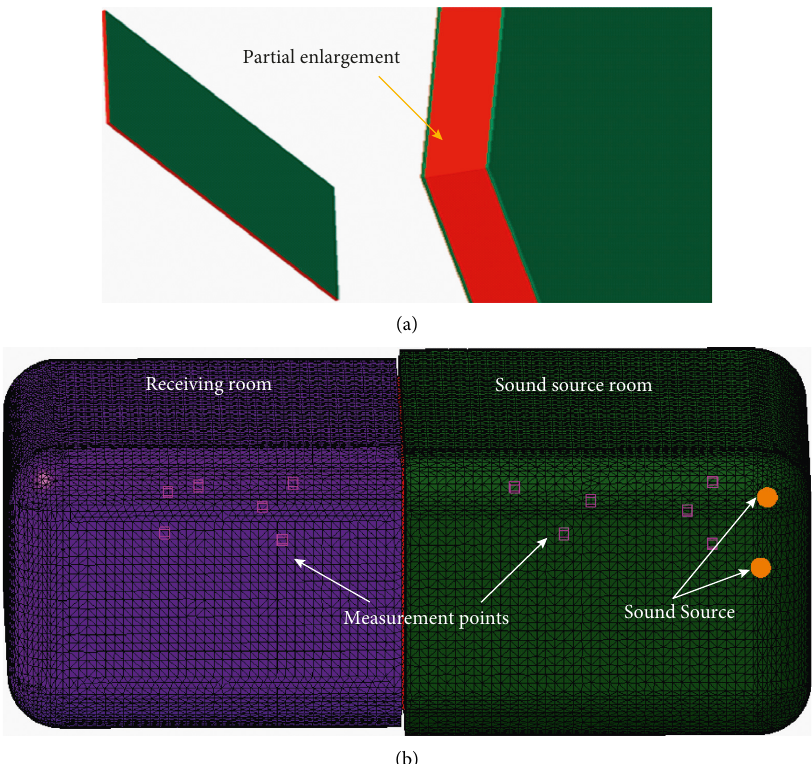
Figure 7: The finite element models: (a) the simulation model of SPS; and (b) the element models of sounding room, receiving room, and the positions of measuring points.